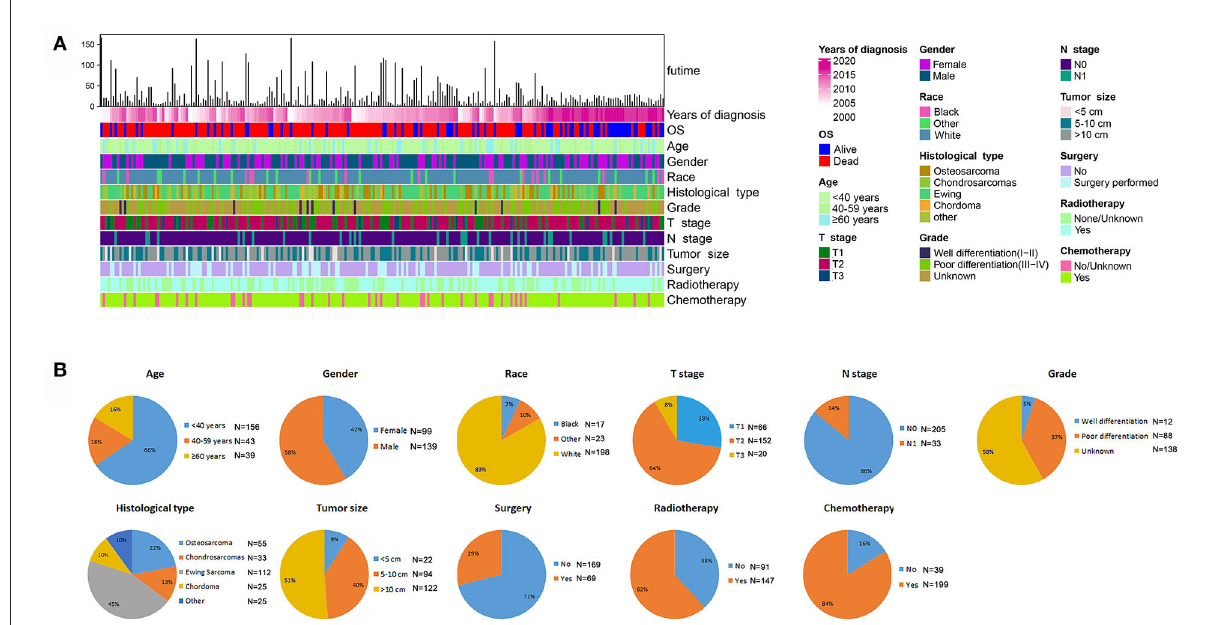
FIGURE6 Integrated bar plot and heatmap of demographics information, tumor characteristics, and clinical outcomes of patients with POSNs with DM (A) . Pie chart of variables in the patients with POSNs with DM (B) .